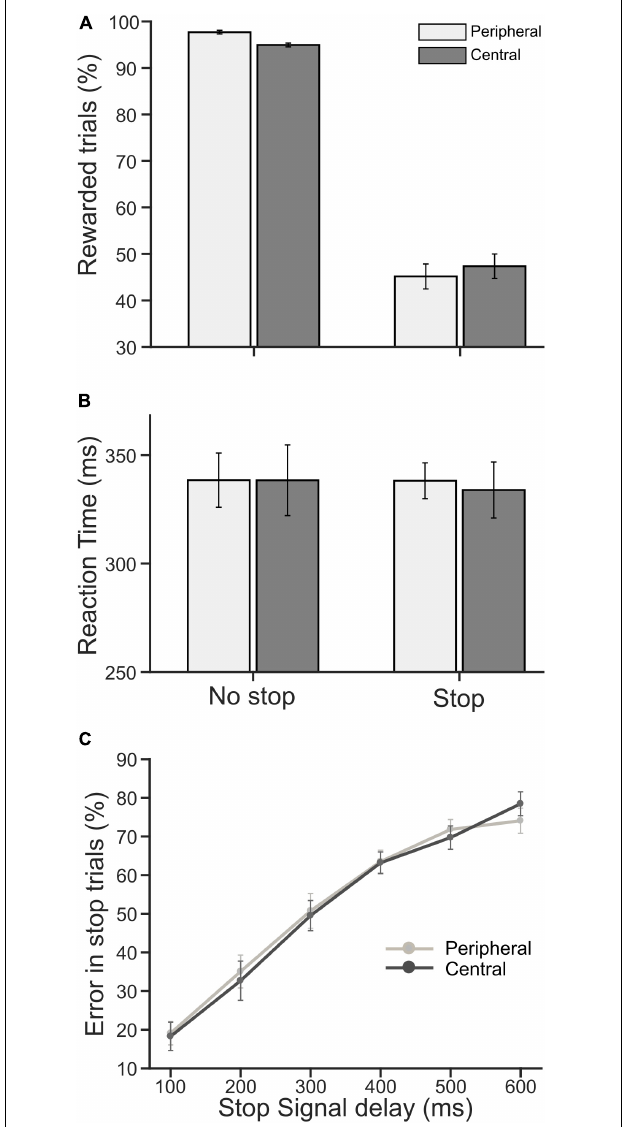
FIGURE 2 | Population average of performance and reaction time (RT). (A) The average percentage of rewarded trials (i.e., correct no-stop and canceled stop trials) in peripheral (light gray) and central (dark gray) cueing for no-stop and stop conditions. (B) The average saccadic RT in correct no-stop and non-canceled stop trials in the peripheral (light gray) and central (dark gray) cueing task. (C) The average percentage of error/failure in stopping a saccade gradually increased as SSD increased in the peripheral (light gray) and central (dark gray) cueing task. Error bars indicate SE of corresponding